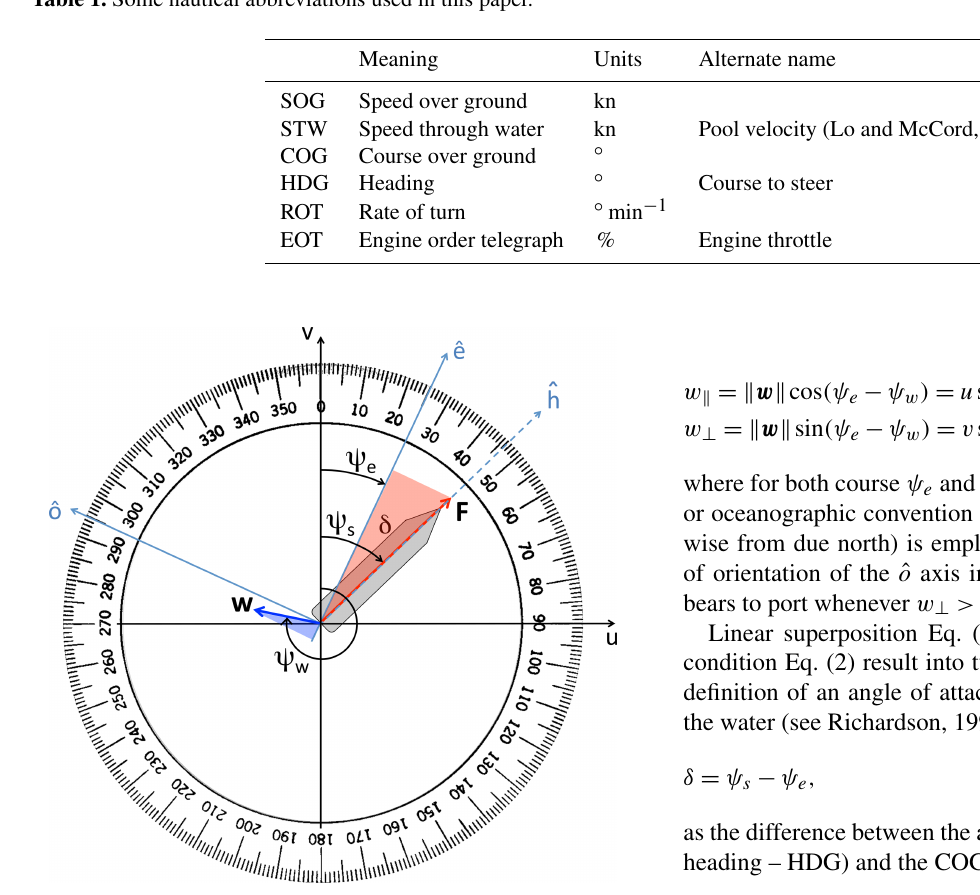
Figure 1. VISIR-1.b directional conventions on top of the compass protractor. Shown is the vessel speed through water ( F ), flow speed ( w ), vessel COG ( ψ e ), vessel heading ( ψ s ), flow direction ( ψ w ), and angle of attack through water ( δ = ψ s − ψ e ). The length of the longer cathetus of the blue triangle is equal to the shorter cathetus of the red triangle and represents the cross-current magnitude w ⊥ = F sin δ ; see Eq. (7). The configuration displayed refers to a vessel course assignment ( ψ e = 25 ◦ ) and implies a positive angle of attack ( δ = 21 ◦ ) which balances the drift due to a port-bearing flow w